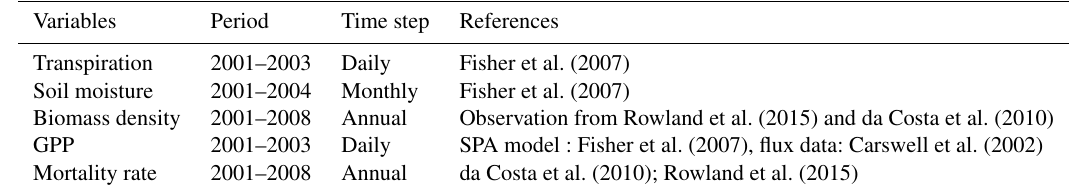
Table 1. Collected observation data used for validation of process-based model